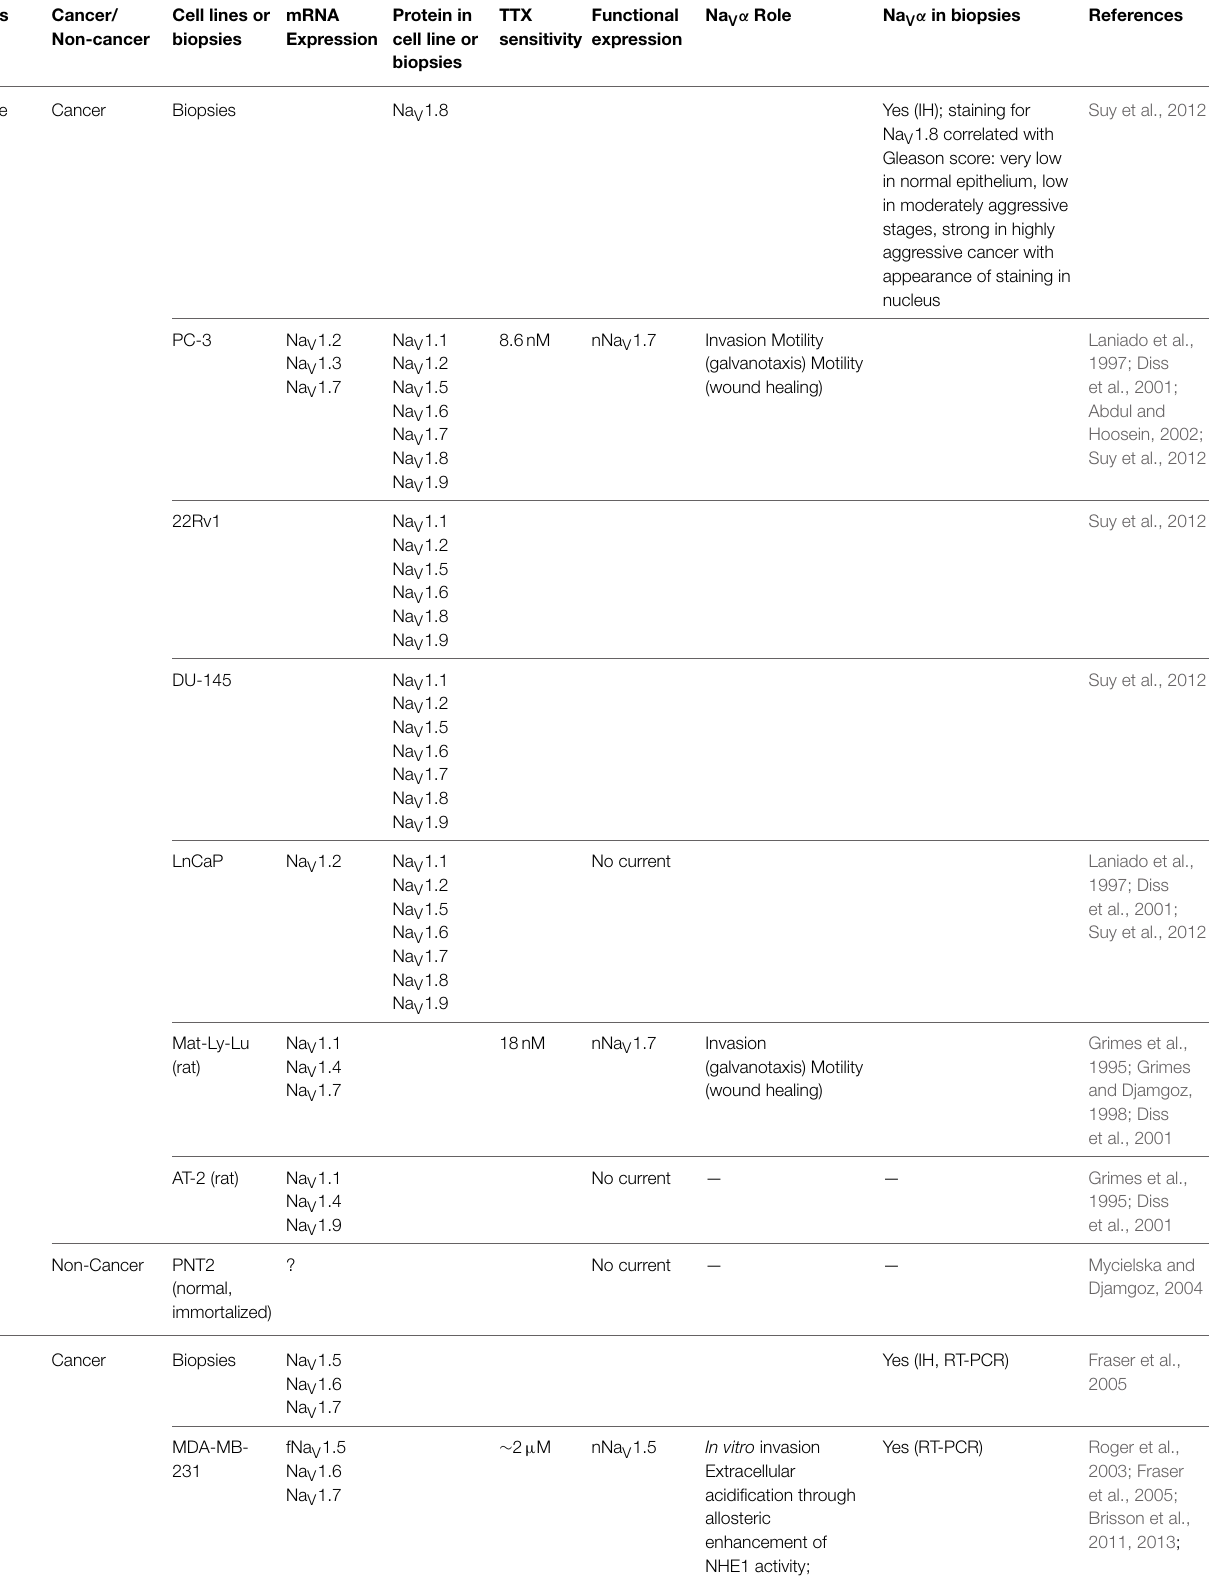
TABLE 1 | List of the non-nervous tissue cancers in which Na V α have been studied.